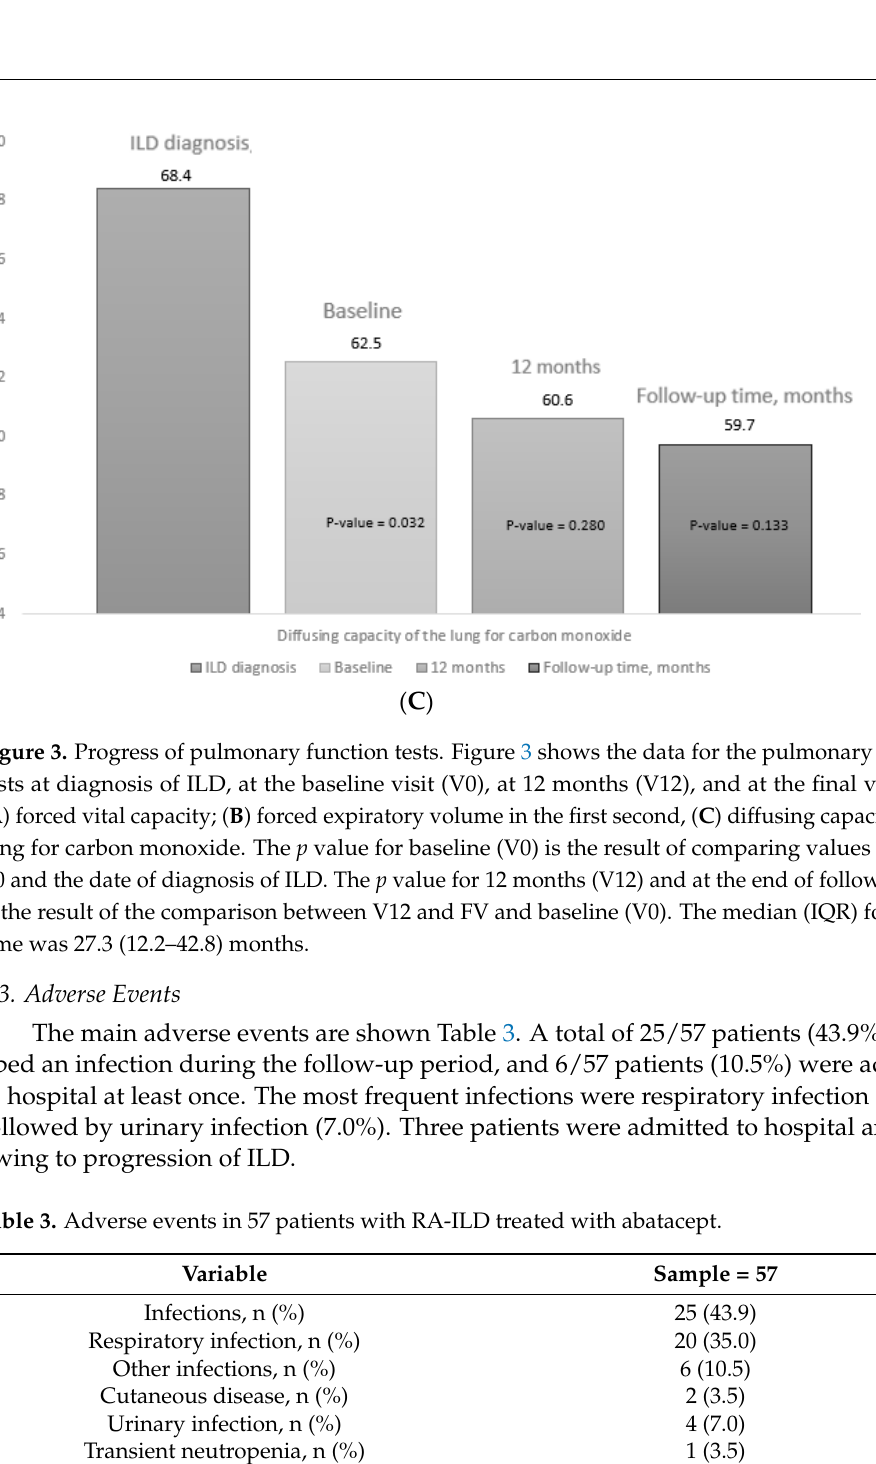
Table 3. Adverse events in 57 patients with RA-ILD treated with abatacept.